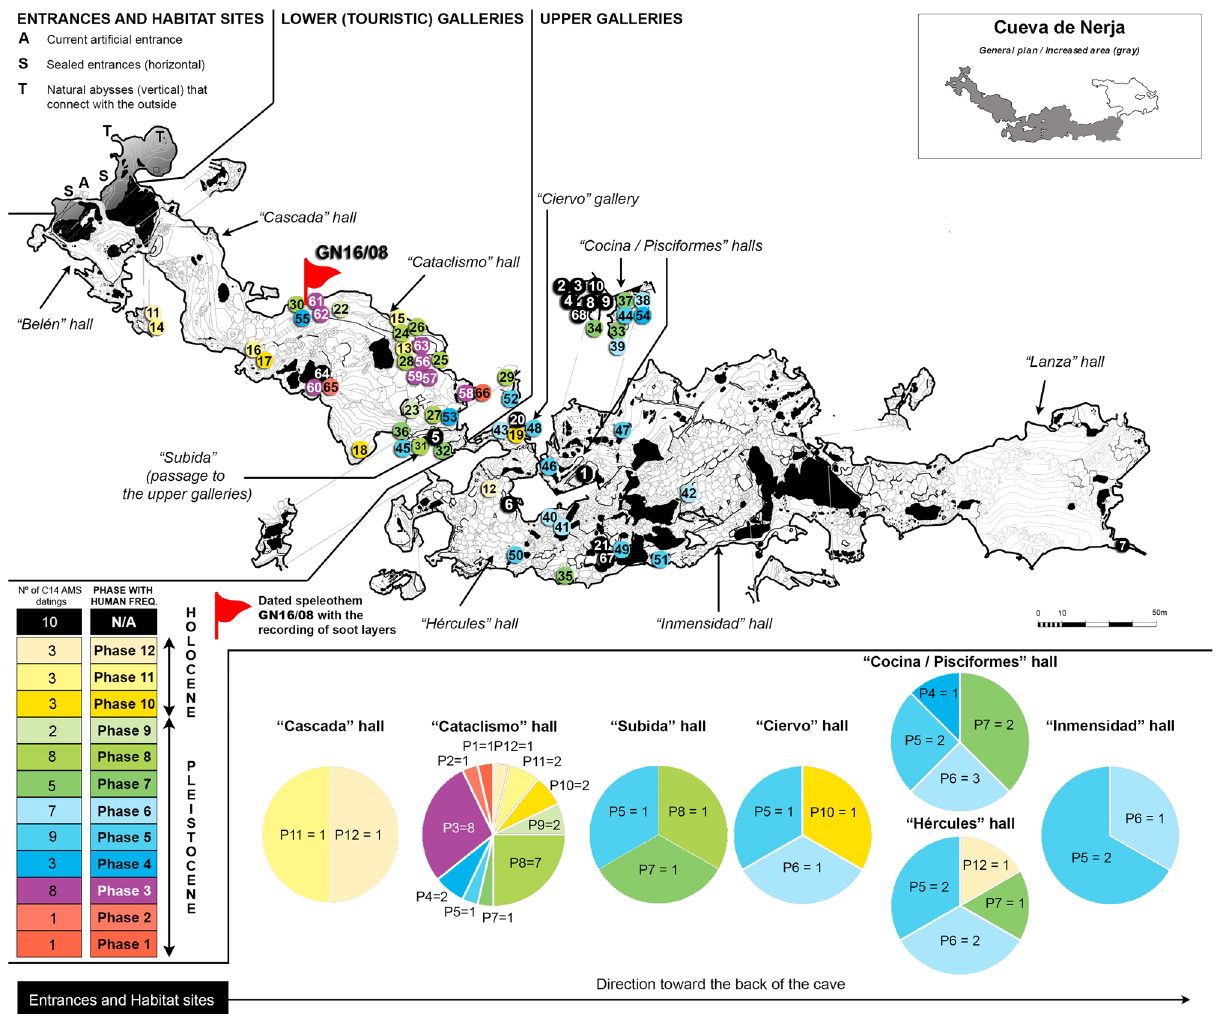
Figure 3. Planimetry of Nerja cave with the location of the analysed samples (modified from Medina-Alcaide 2019 27 ). Circles indicate the charcoal samples dated by 14 C, and the red flag marks the place of the stalagmite GN16-08 with the micro-levels of soot. The colour of the circles corresponds to the Bayesian phases from charcoal dating. In the lower right part of the image, the number of phases is represented by means of circle graphs for each room of the cave. Specific information about each sample can be found in “Supplementary Materials”. The numbers in the circles correspond to the number of